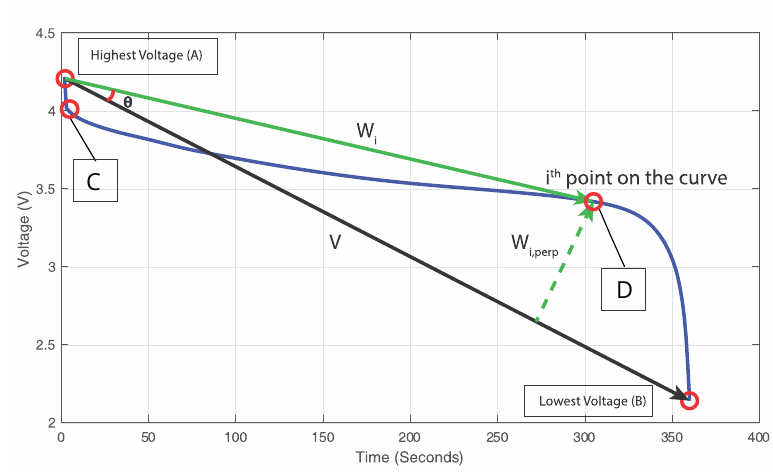
Figure 4. Knee points